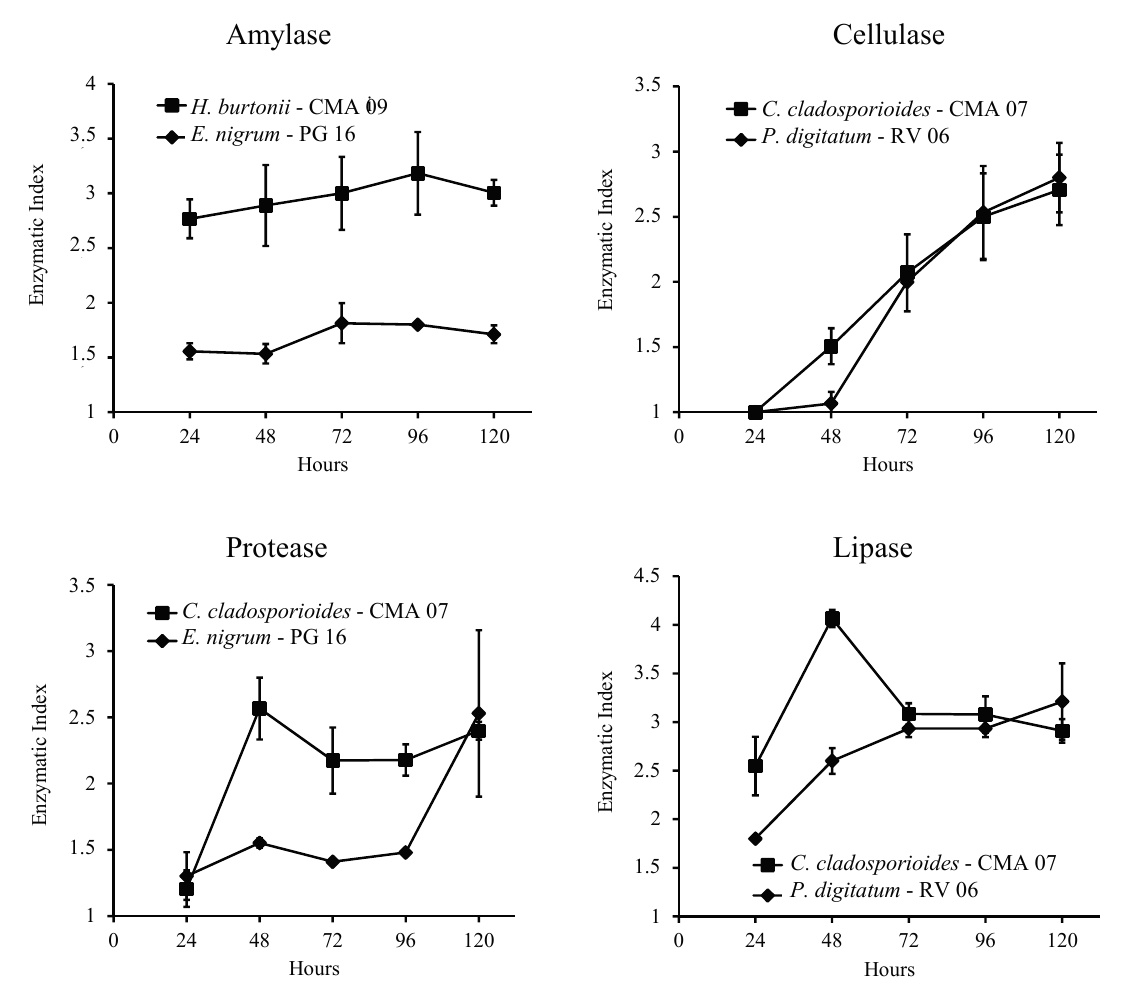
Figure 4. Time course of extracellular enzyme production by fungal producers on solid media containing the corresponding substrates. Enzymatic activity is expressed as Enzymatic Index (halo diameter/colony diameter). A known producer ( ■ ) and a novel producer ( ♦ ) were